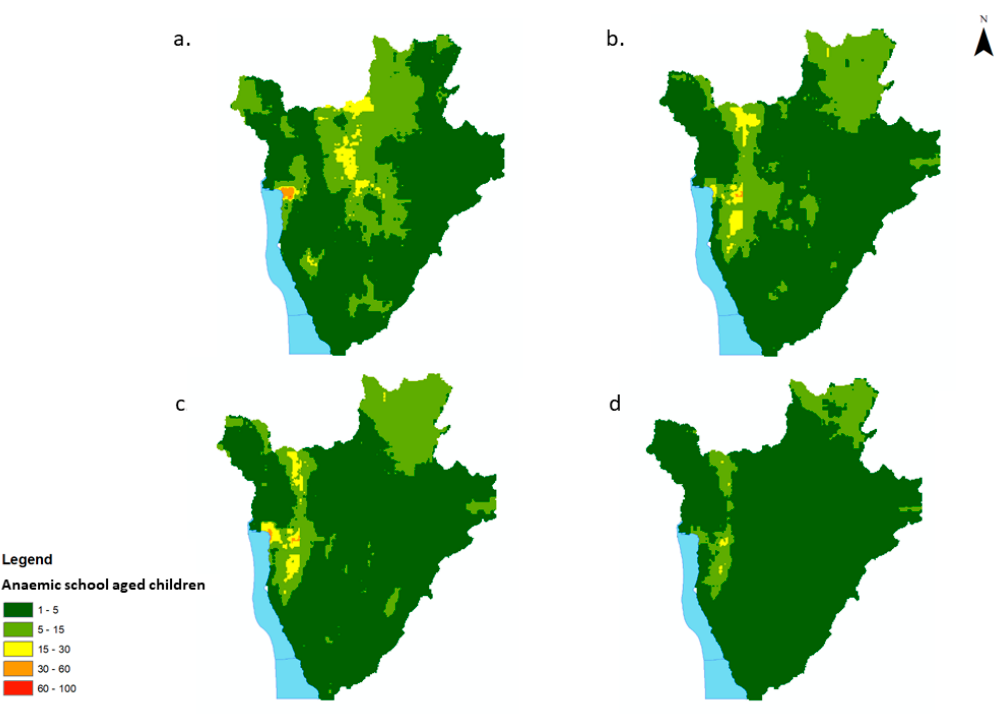
Figure 6. Estimated number of school-aged children (5–15 yrs) with moderate/high-severity anaemia in Burundi, 2008–2011, per 550 m 2 . ( a ) 2008, ( b ) 2009, ( c ) 2010, ( d ) 2011.